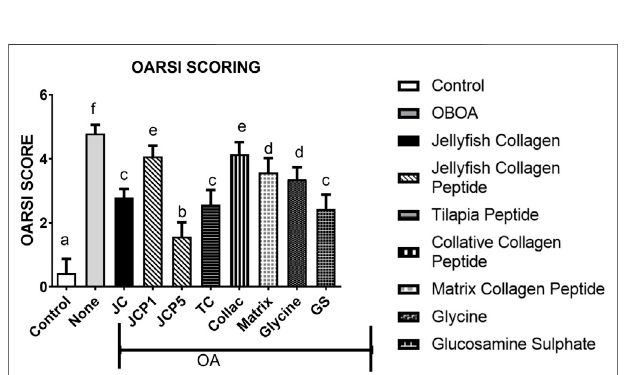
FIGURE 6 | OARSI scoring of rats knee.